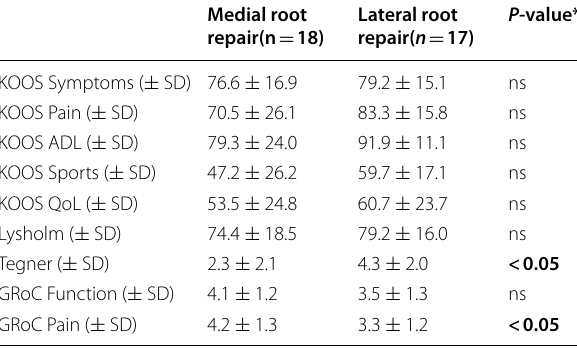
Table 3 Patient reported outcome (mean for medial and lateral posterior meniscal root repairs at